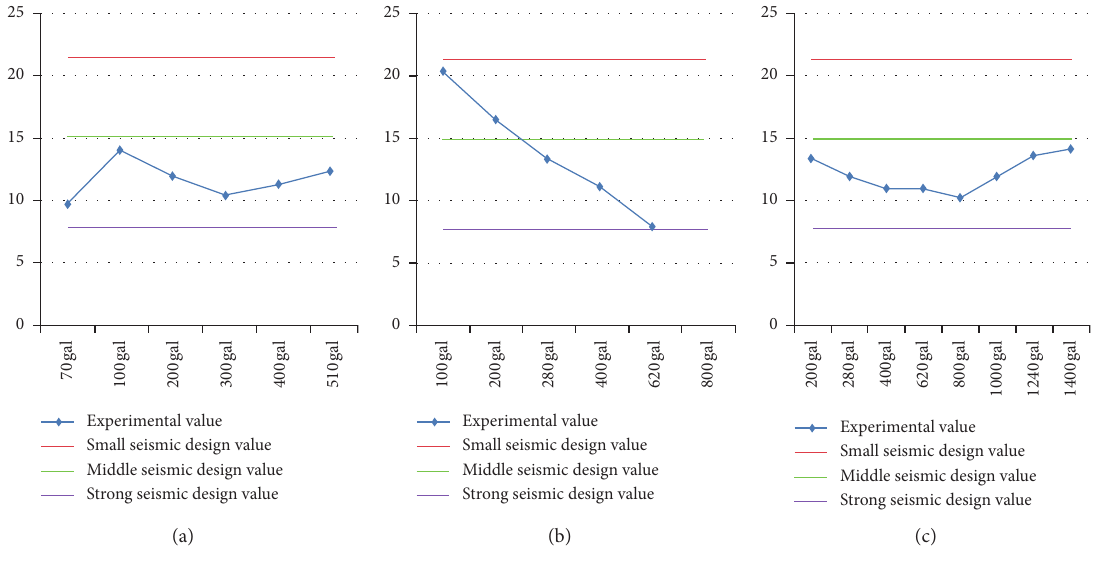
Figure 14: Equivalent viscous damping ratio: (a) MLQT-2; (b) MLQT-3; (c)